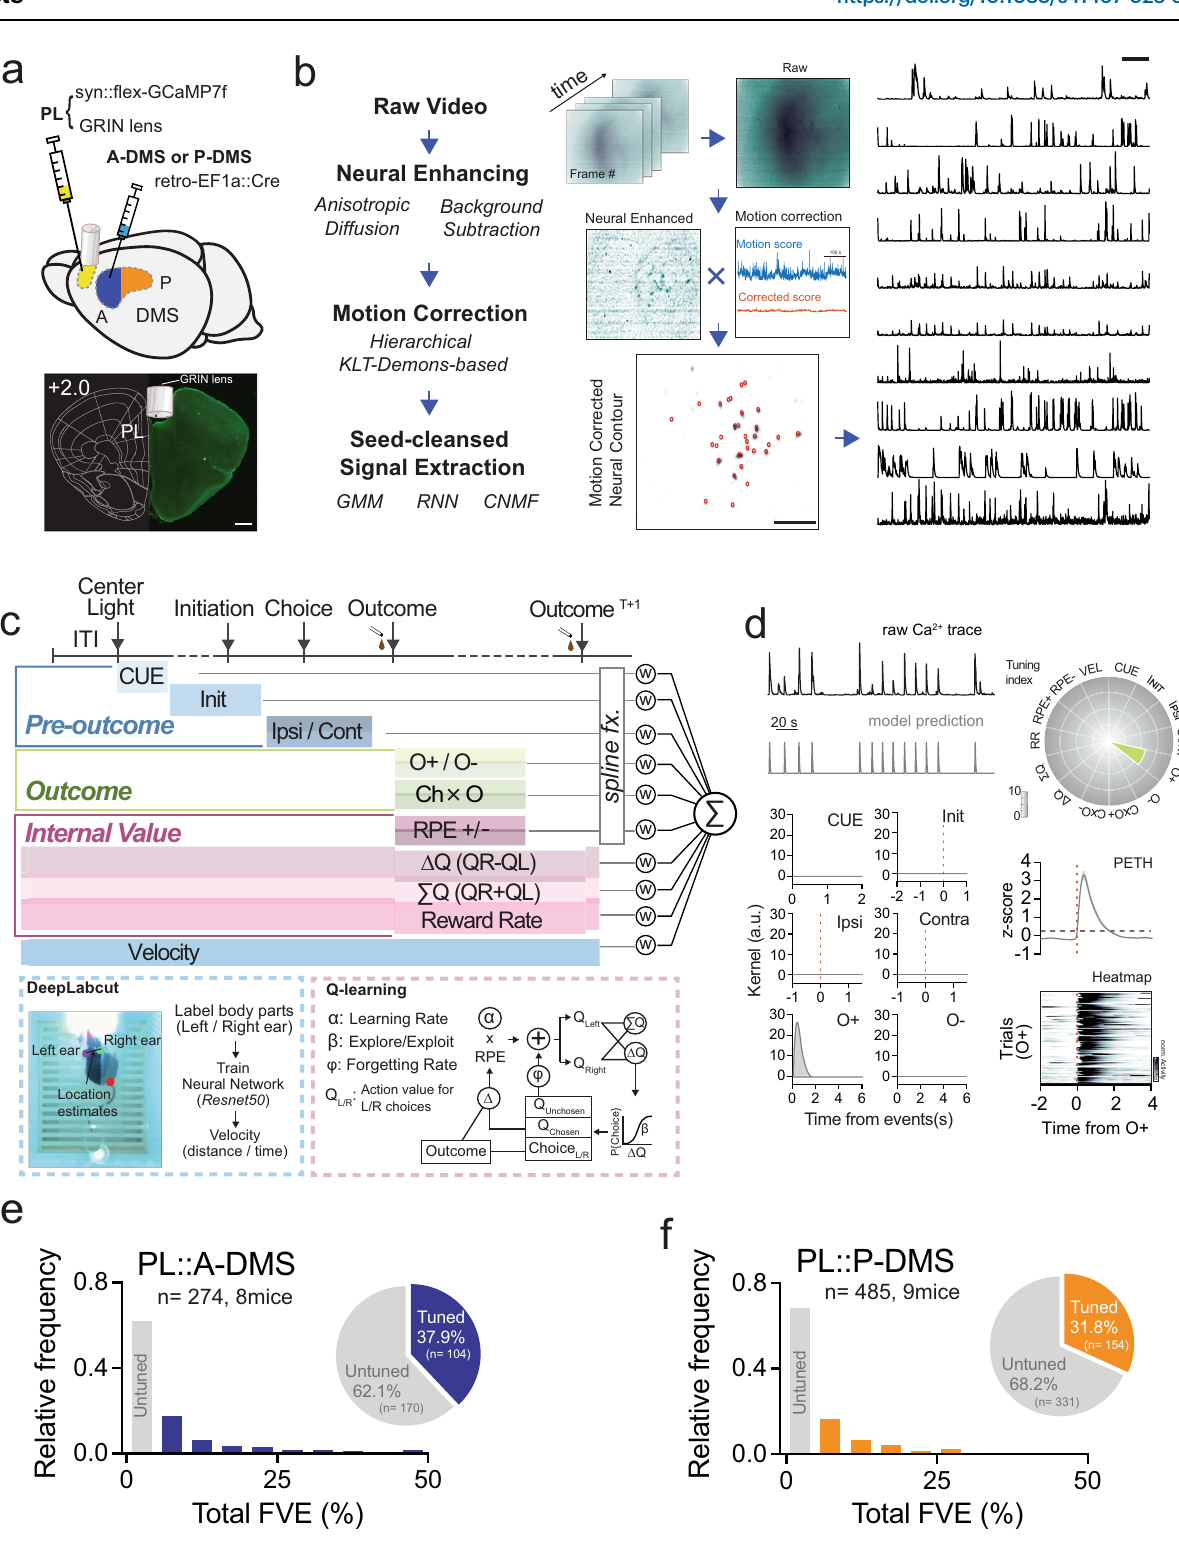
outcomes of the PL::A-DMS, but not the PL::P-DMS, caused a decrease in lose-staychoice(Fig. 8e,f). This optogenetically-induced decreasein lose-stay behavior was consistently observed for PL::A-DMS inhibition across a range of reward probability environments (Fig. S11f). In low probability reward environments ( P rew =0.4), inhibition of